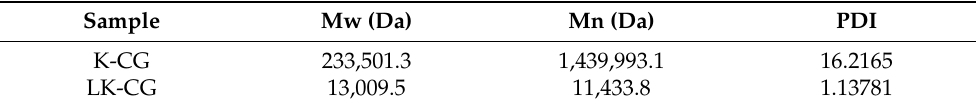
Table 1. The Mw, Mn, PDI of K-CG and LK-CG.